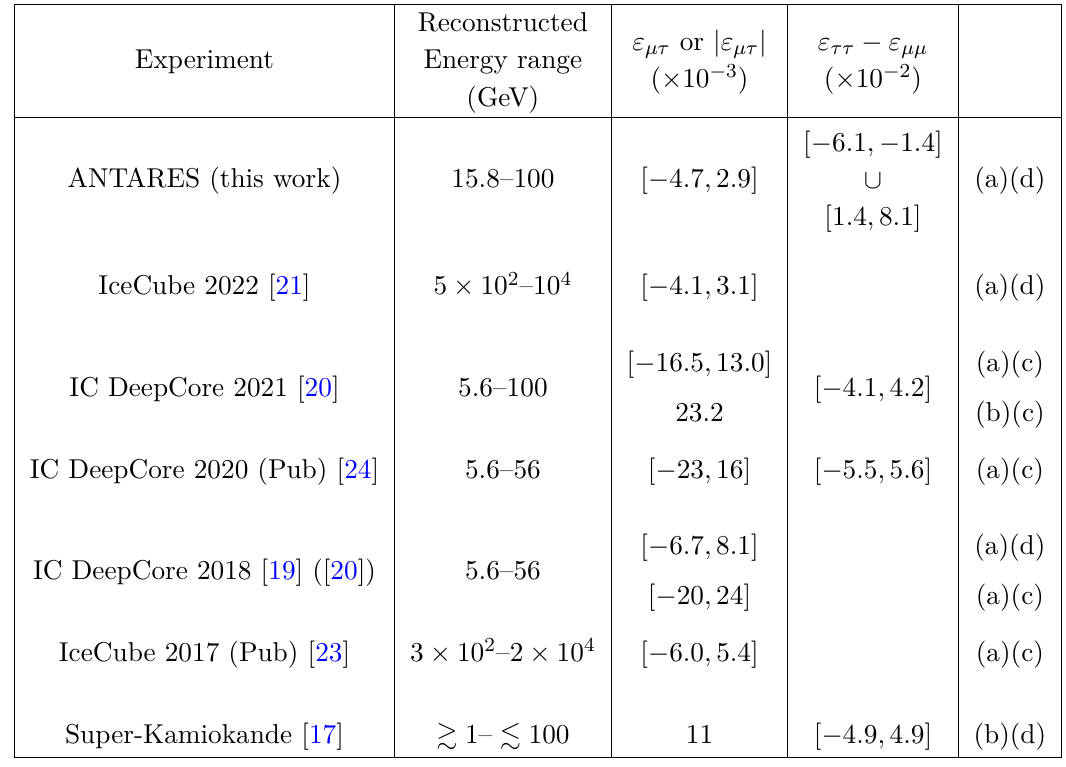
Table 2 . Summary of the 90% CL upper limits on the NSI parameters ε µτ (or | ε µτ | ) and ε ττ − ε µµ from different atmospheric neutrino experiments. The intervals indicate the regions not excluded by the corresponding analysis. For | ε µτ | the single upper limit is given. The label “Pub” indicates that the public data have been analysed by researchers outside the collaboration. The conditions applied are as follows: (a) assuming real ε µτ , (b) modulus of complex ε µτ , (c) for effective NSI couplings and (d) for d-quark NSI couplings. All the results are given for normal ordering. The approximate neutrino energy range used in each analysis is also shown. See the main text for